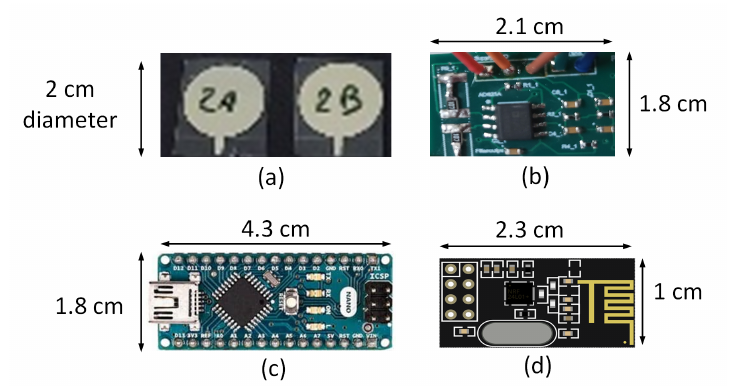
Figure 2. ( a ) Zeolite-based dry electrodes ( b ) Read-out-circuit ( c ) ADC ( d ) nRF24L01 wireless transreceiver.